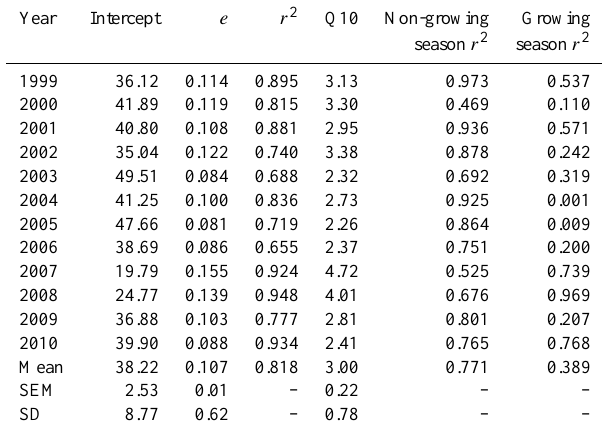
Table 5. Coefficients of an exponential model-fitted monthly R eco to mean monthly air temperature, calculated mean Q10 values and r 2 values for the Straits Inclosure, Alice Holt Forest. r 2 values are also shown for exponential regressions for the non-growing (November–March) and growing (April–October) season months, separately.